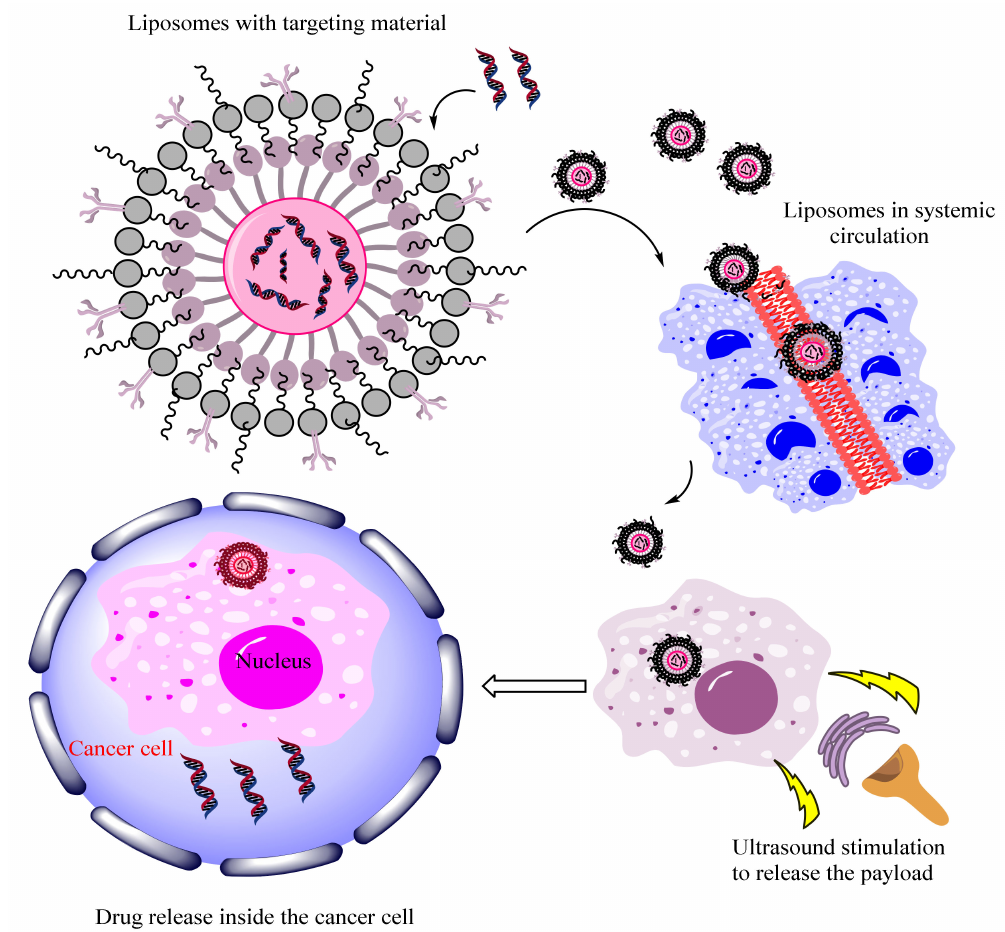
Figure 3. Demonstrated the application of ultrasound responsive liposome-carrier system for cancer